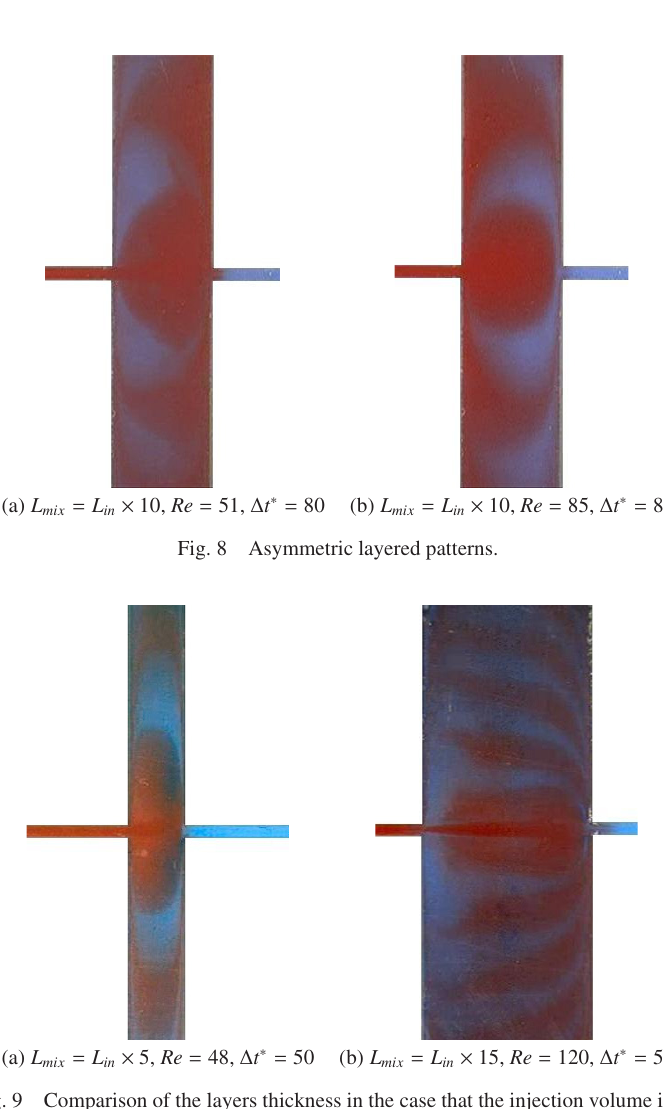
Fig. 9 Comparison of the layers thickness in the case that the injection volume is the